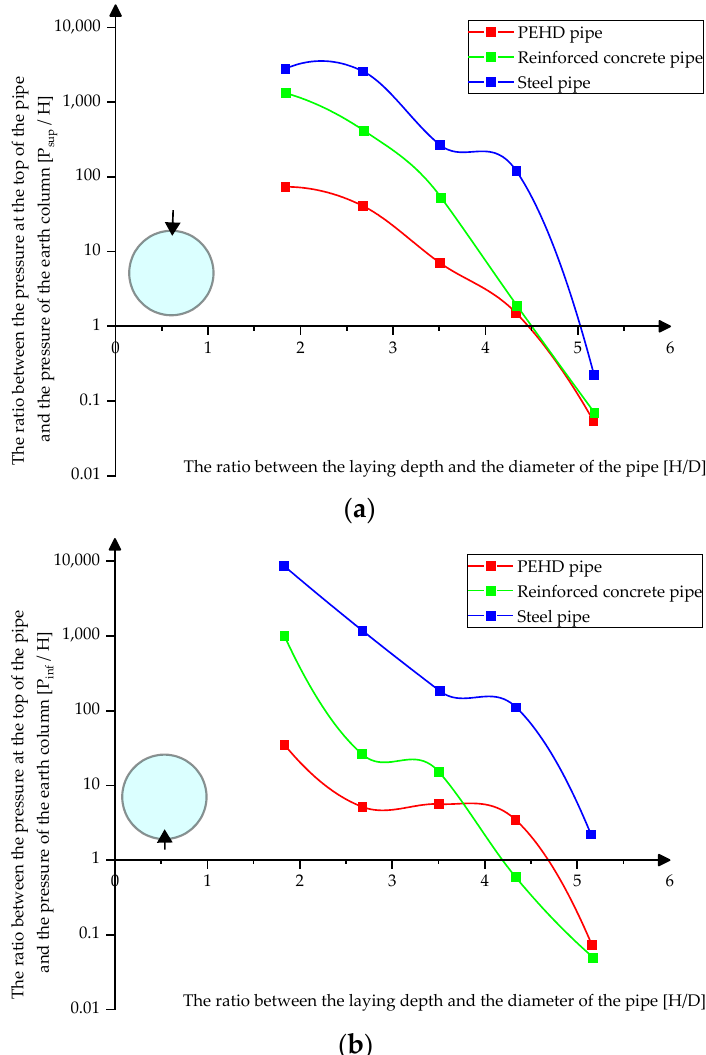
Figure 9. Variation of pressures on pipes in loose sands ( a ) at the top of the pipes ( b ) at the bottom of the pipes.